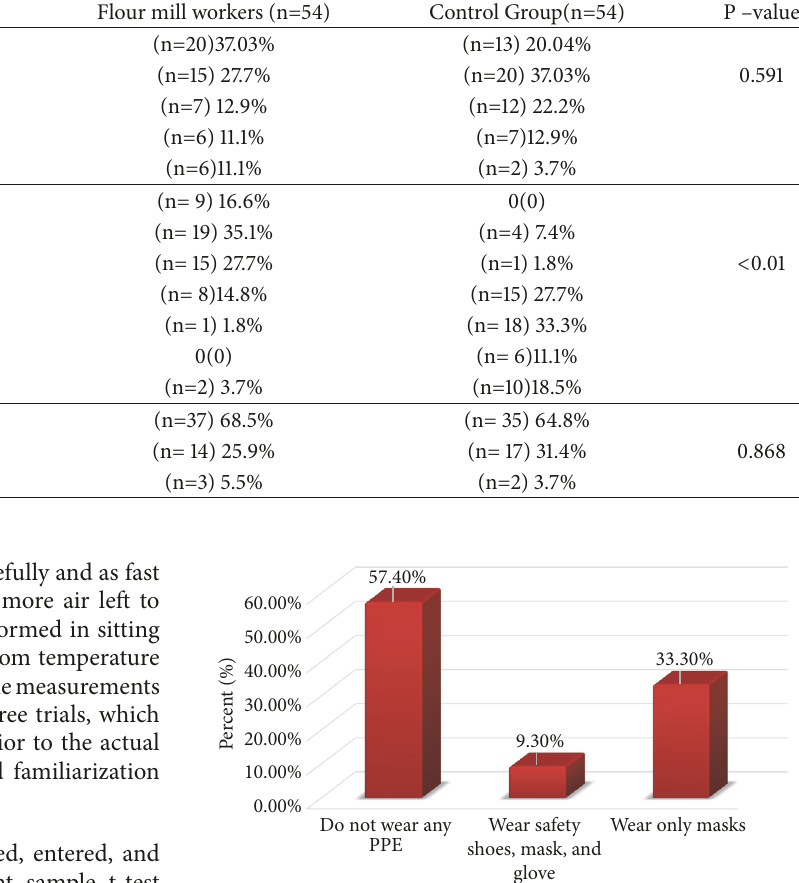
Table 1: Sociodemographic information of flour mill workers and controls.